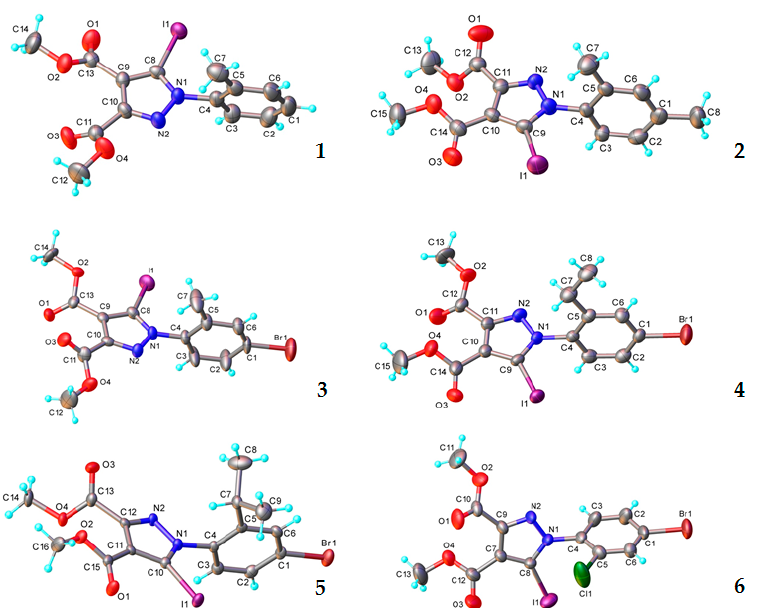
Figure 3. X-ray molecular structures with atom labeling and thermal ellipsoids at the 50% level for the compounds 1 – 6 .